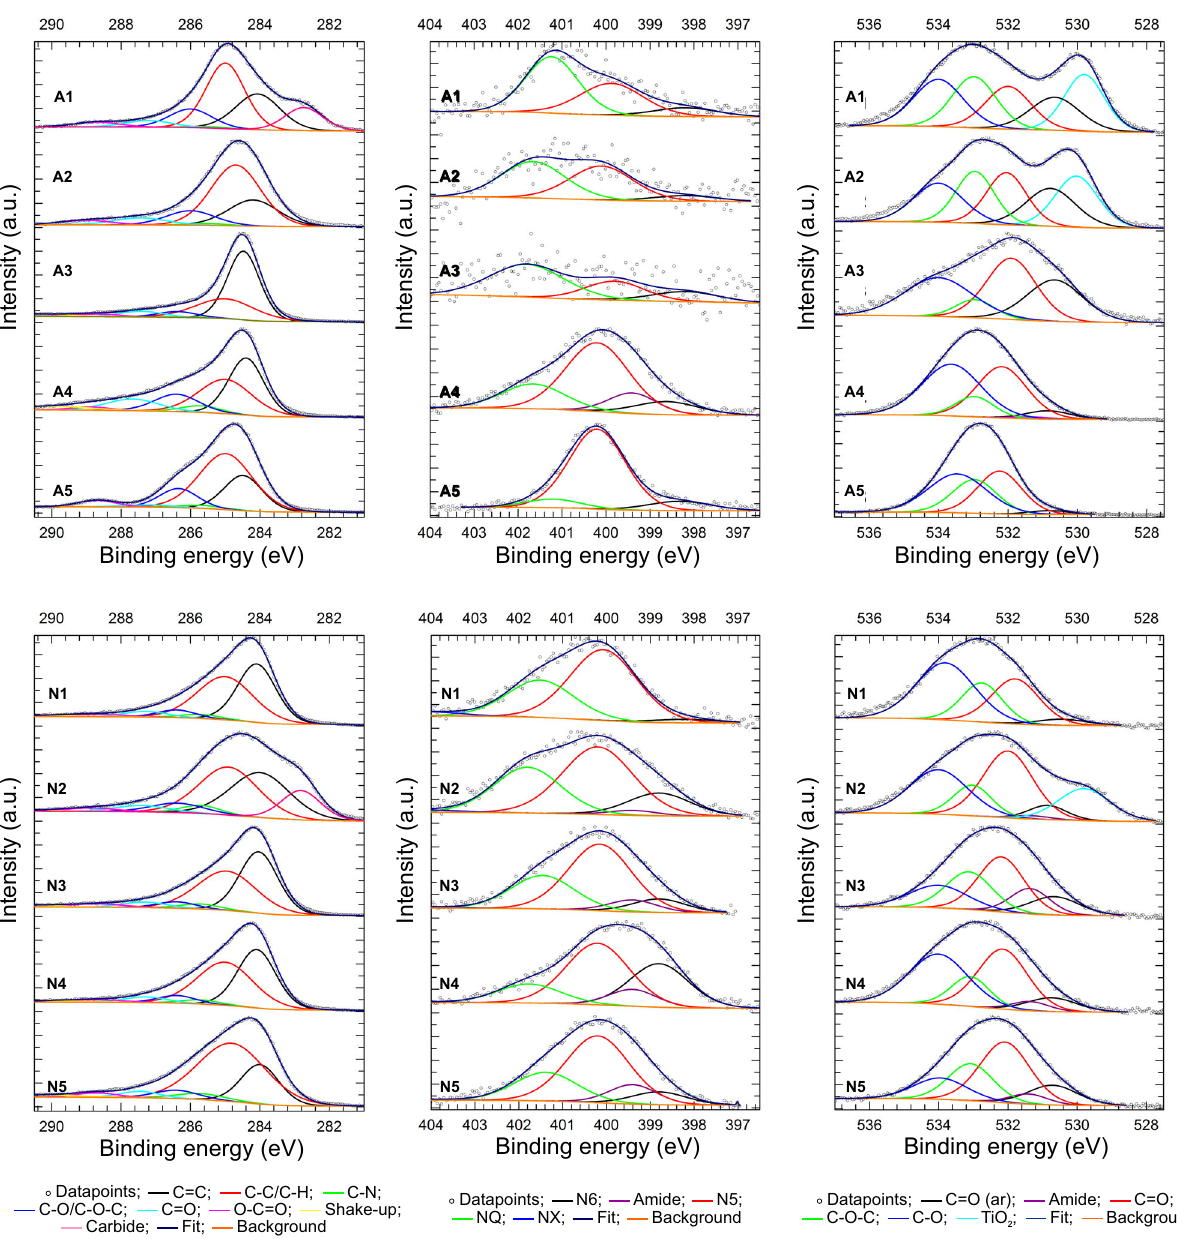
Fig. 3 Deconvoluted XPS spectra of C 1 s , N 1 s , and O 1 s lines of laser-induced carbon fabricated in (top) air and (bottom)